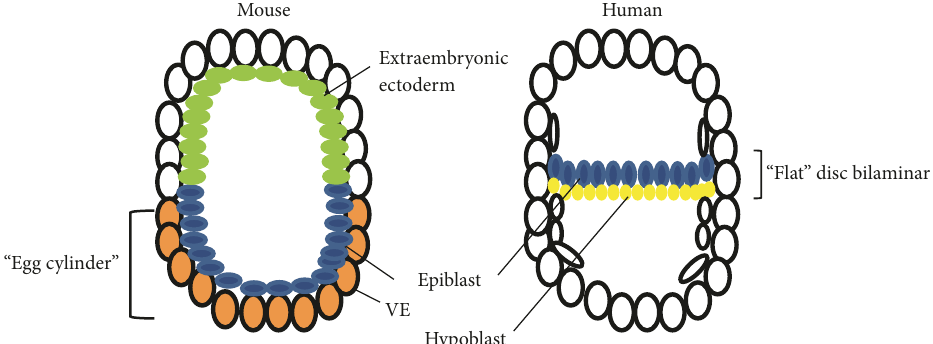
Figure 1: Differences between mouse and human embryos. Mouse embryo has the shape of an egg cylinder (showing the apposition the epiblast and visceral endoderm tissues) and human embryo has the shape of a flat disc with two layers of cells known as epiblast and hypoblast. VE: visceral endoderm. Adapted from Irie et al.,